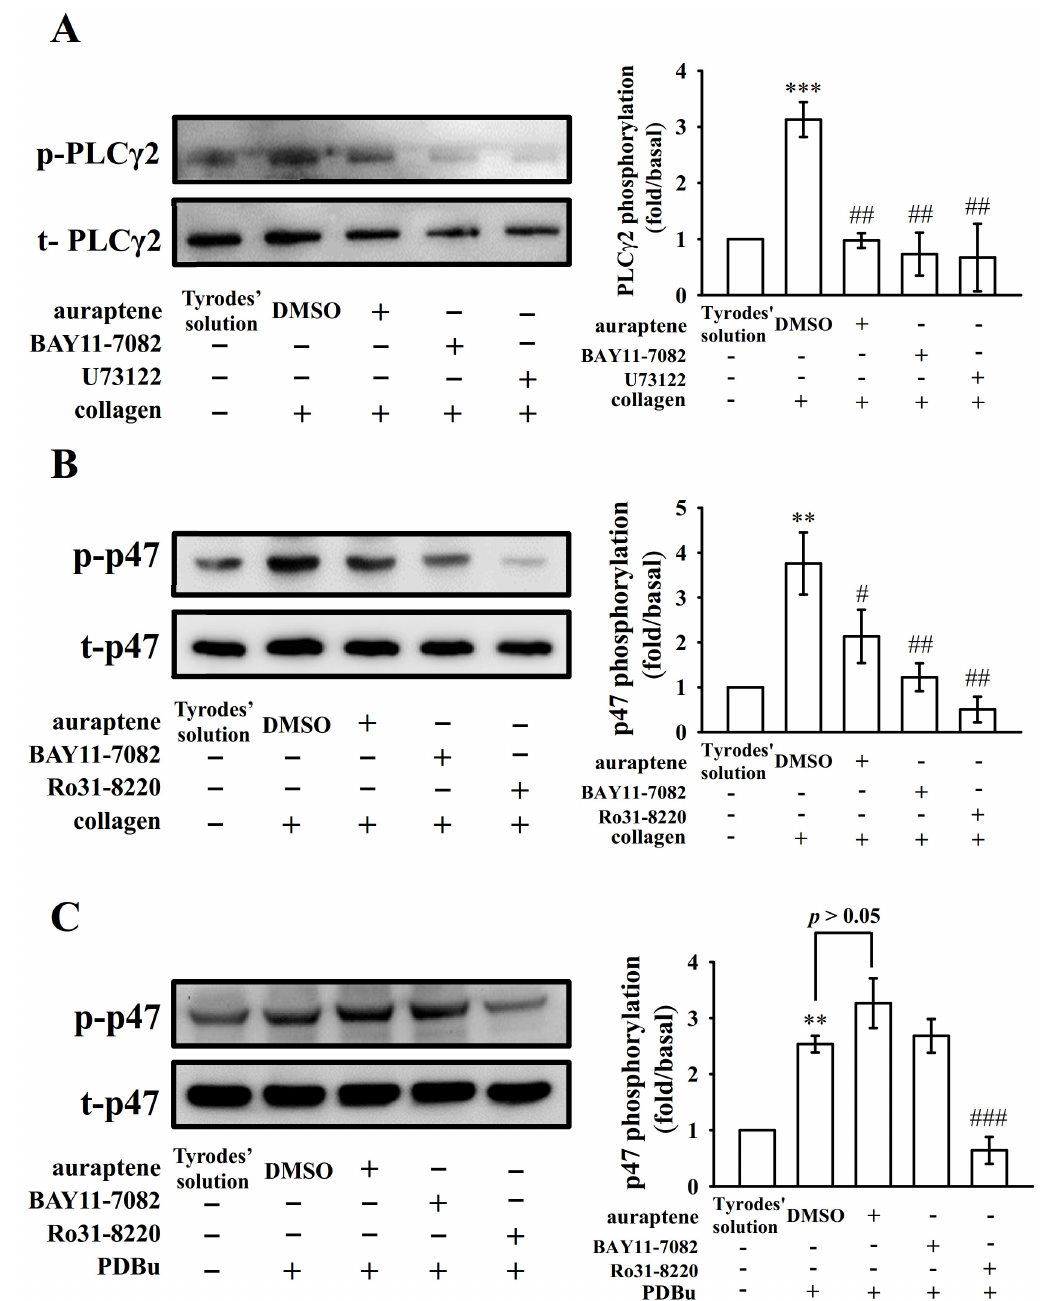
Figure 3. Regulatory effects of NF- κ B inhibitors and auraptene on PLC γ 2 phosphorylation and PKC activation. Washed platelets were preincubated with 0.1% DMSO, auraptene (60 μ M), BAY11-7082 (10 μ M), U73122 (5 μ M), or Ro31-8220 (2 μ M) and then treated with collagen (1 μ g/mL) or PDBu (150 nM) to trigger either ( A ) PLC γ 2 phosphorylation or ( B – C ) PKC activation (p-p47). The corresponding statistical data are displayed on the right panel of each figure. Data are given as means ± SEM ( n = 4). ** p < 0.01 and *** p < 0.001, compared with the resting platelets (Tyrode’s solution); # p < 0.05, ## p < 0.01, and ### p < 0.001, compared with the 0.1% DMSO-treated group.